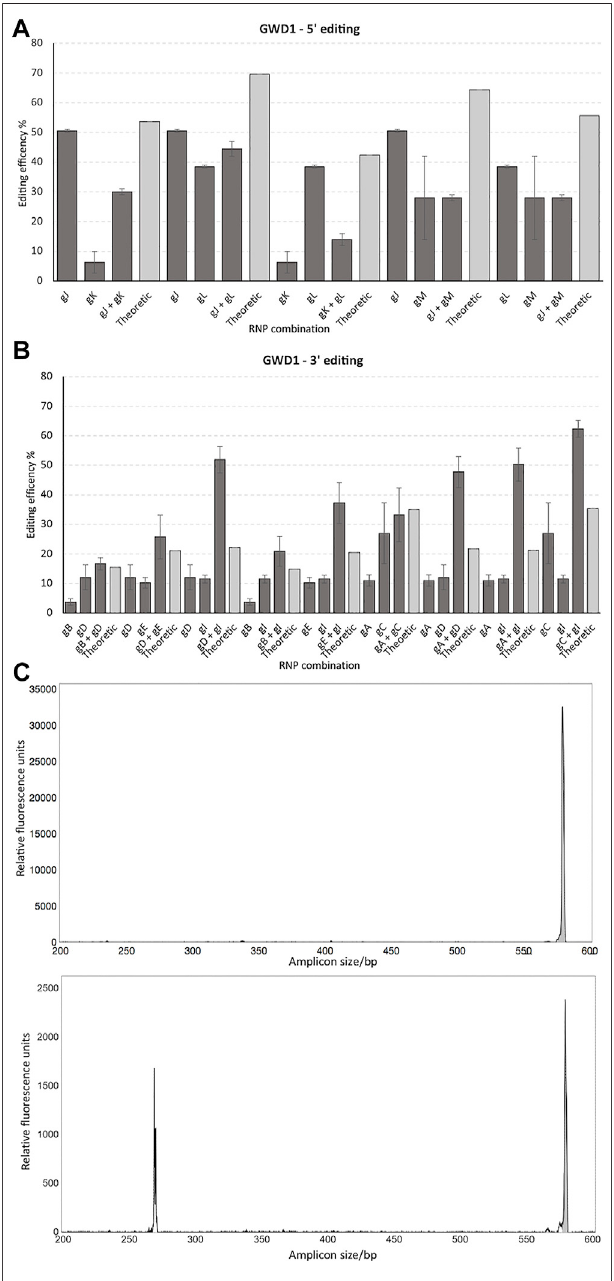
FIGURE 3 | Targeting the 5 ′ versus the 3 ′ end of GWD1 and effect of multiplexing. 4 and 6 gRNAs were designed for the 5 ’ (gJ, gK, gL, and gM) (A) and 3 ’ (gA, gB, gC, gD, gE, and gI) (B) end ofGWD1, respectively. The gRNAs were tested individually and in combination. Theoretical designates the probability of editing, calculated as the multiplied probabilities ofeach gRNA notconferring editing,(1 – gRNA1editingfraction)*(1 – gRNA2 editing fraction) subtracted from 1, i.e., 1 – [(1 – gRNA1 editing fraction) * (1 – gRNA2 editing fraction)] * 100 (%), where 1 designates all alleles in the cell pool. (C) :IDAAchromatogramofWTamplicon(upperpanel,grey)andgDand gI combined editing (lower panel) including the unedited WT amplicon (grey) andminor editing from either gDor gI and where the lower sized amplicons include the combined editing of gD and gI andthus the gD and gI delineated